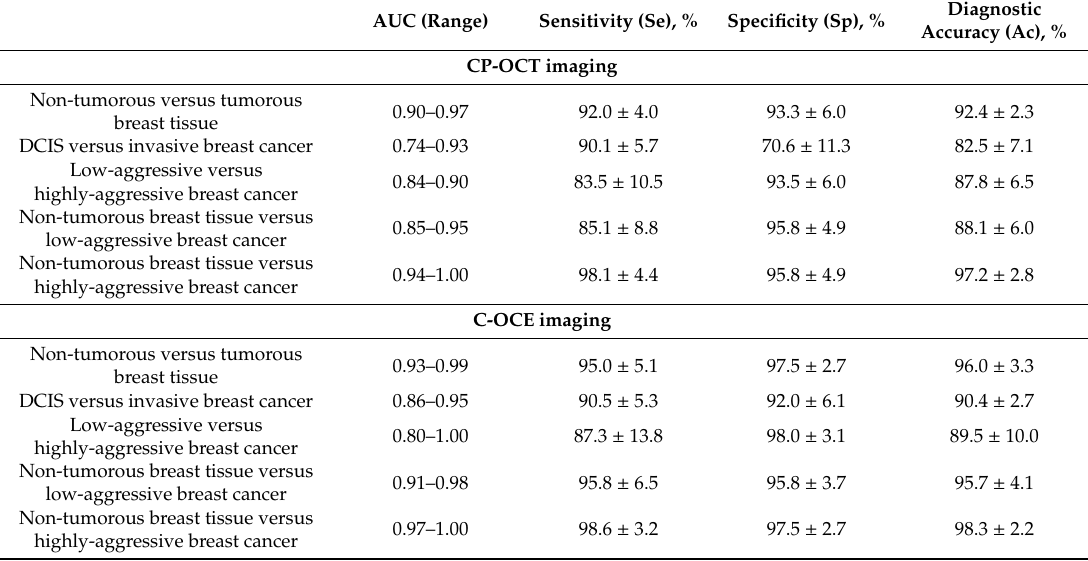
Table 4. The results of diagnostic test for visual assessment of the CP-OCT and C-OCE images.